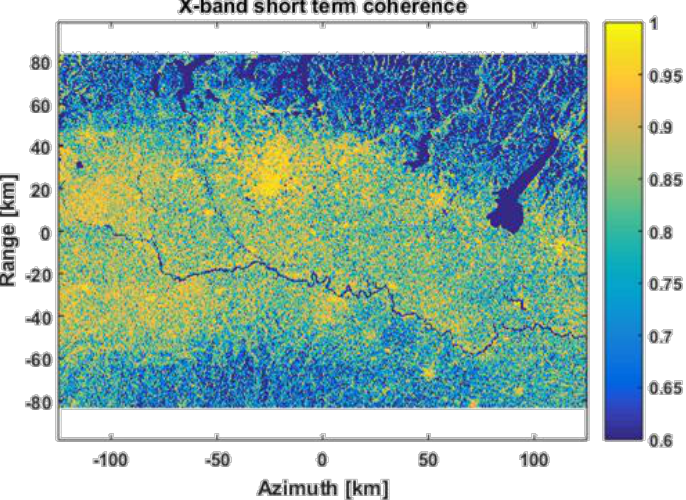
Figure 26. GEO SAR X-band simulation. Coherence between the reference image, shown in Figure 21, and the image affected by clutter, shown in Figure 23. The interferometric revisit is 450 s, see Table 1.